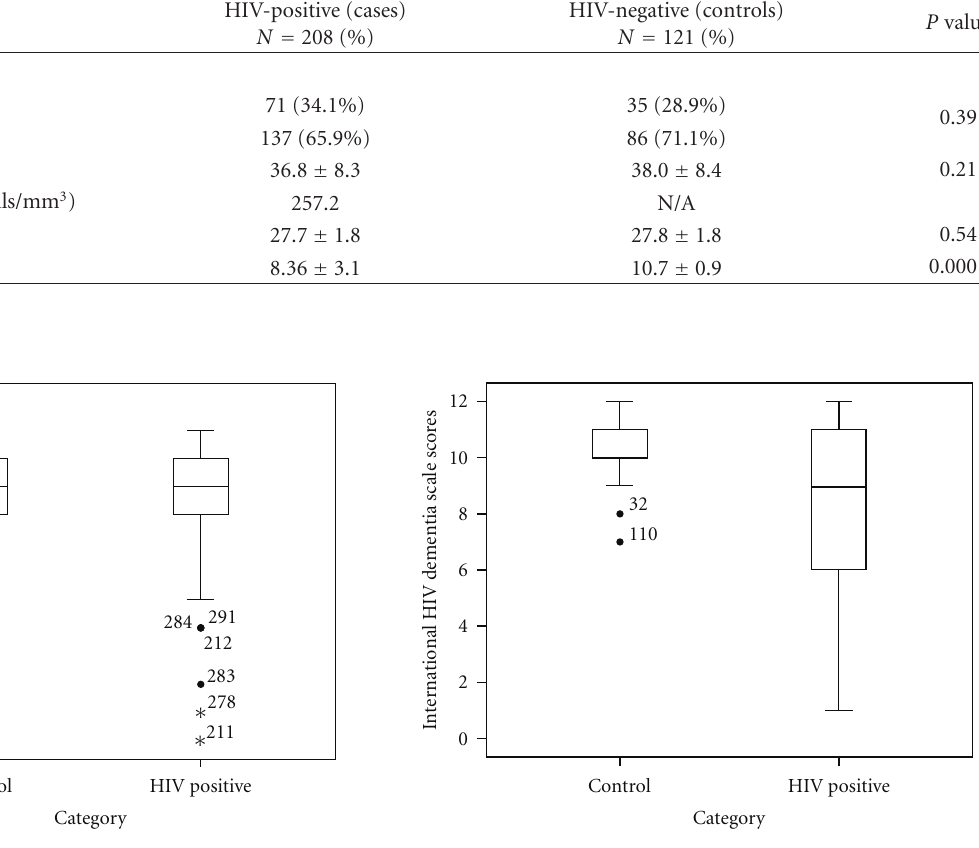
Figure 2: Comparison of IHDS scores in HIV-positive cases and HIV-negative controls. Box plot illustrating the distribution of IHDS scores in cases and controls. The mean (SD) score of the controls (10 . 7 ± 0 . 9) and HIV-positive cases (8 . 36 ± 3 . 1) di ff ered significantly (ANOVA; P < 0 . 0001). Asterisked cases represent outliers within the control group with scores below the group